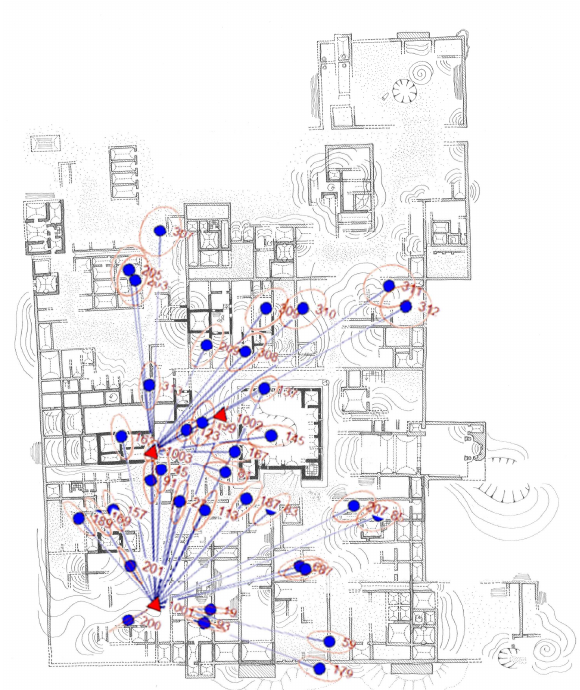
Figure 4. The topographic network. The red triangle are the tree base station.